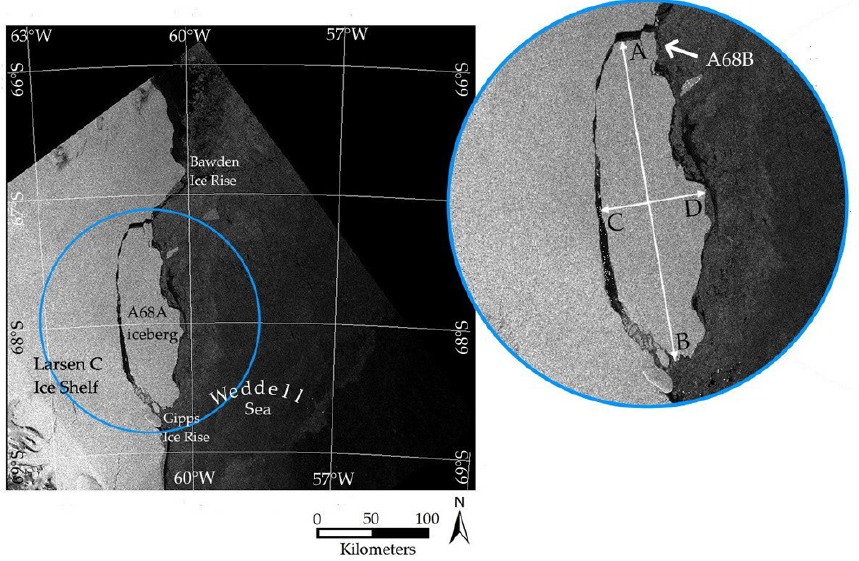
Figure 1. Sentinel-1 scene of A-68 tabular iceberg acquired on 22 July 2017, only a few days after the calving event. The first derived parameters of this huge tabular iceberg were: the length of its major (segment AB) and minor (segment CD) axes, which were 157.5 km and 47.3 km,